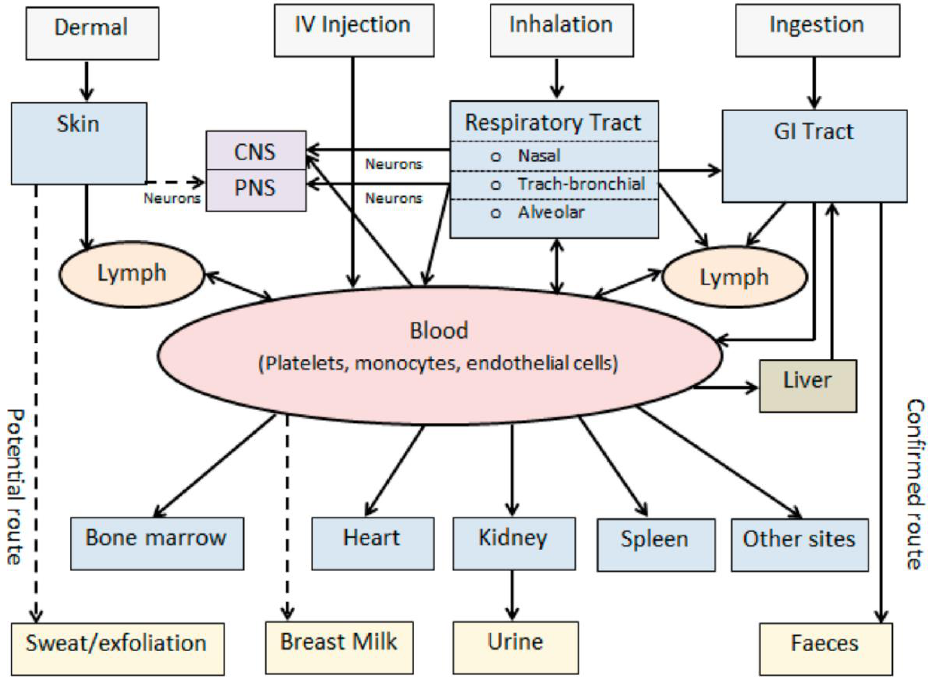
Figure 4. Schematic representation of the various routes of nanoparticle exposure and their biokinetic pathways helpful in nanoparticle safety and toxicological implications in vivo; reproduced with permission from [127] .